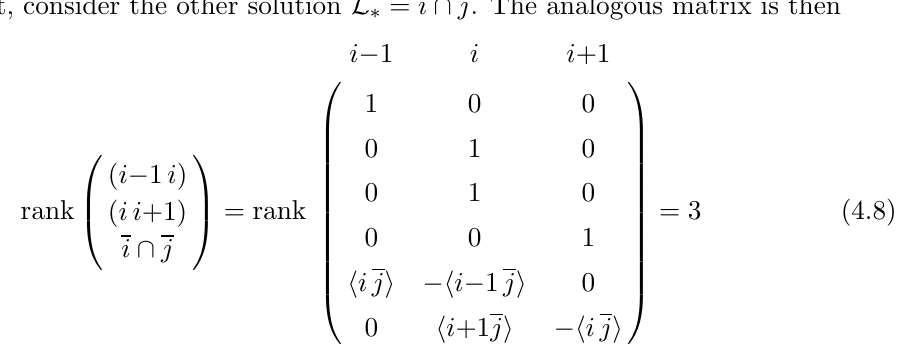
j . The analogous matrix is (cid:3) = i L \